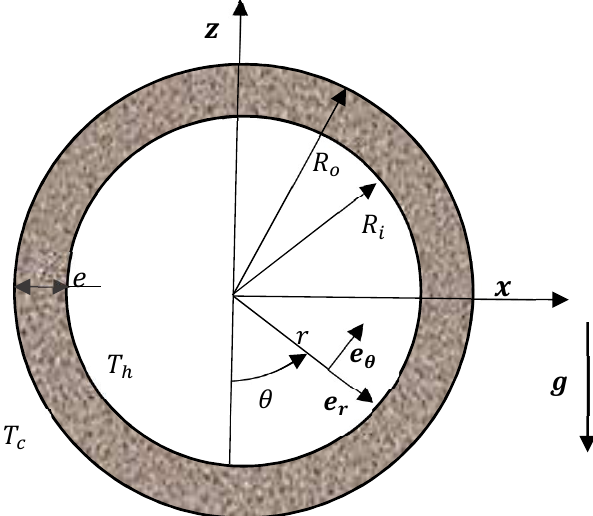
Figure 1. Schematic diagram of horizontal cylindrical TGC.